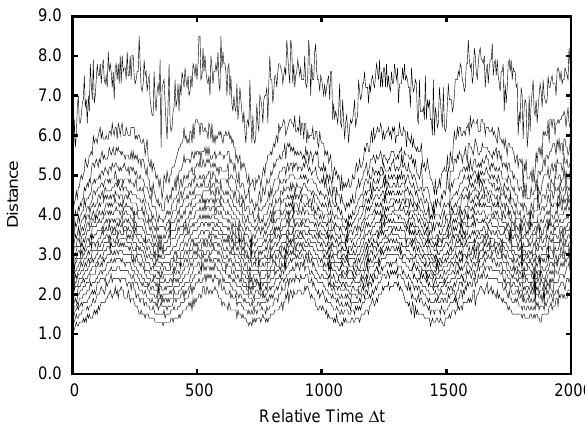
Fig. 2. Space-time separation plot for the time series in Fig. 1 for τ = 1 and m = 14.